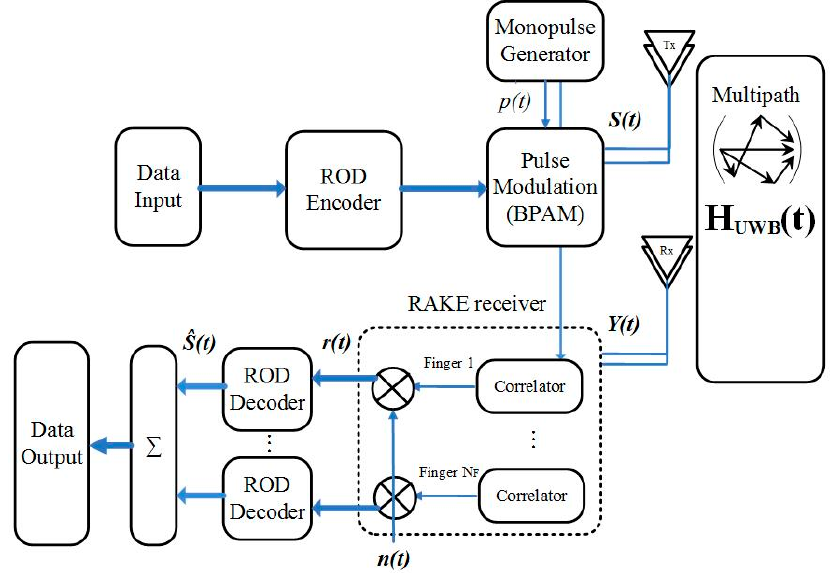
Figure 1. System block diagram.